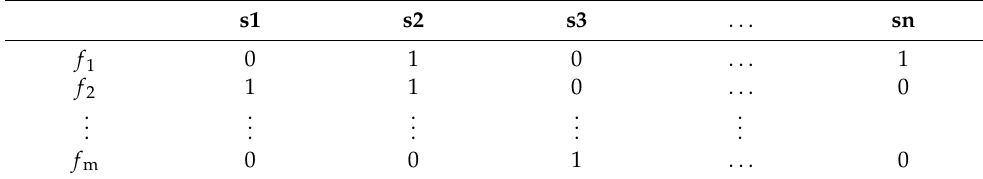
Table 2. Fault Sensor mapping